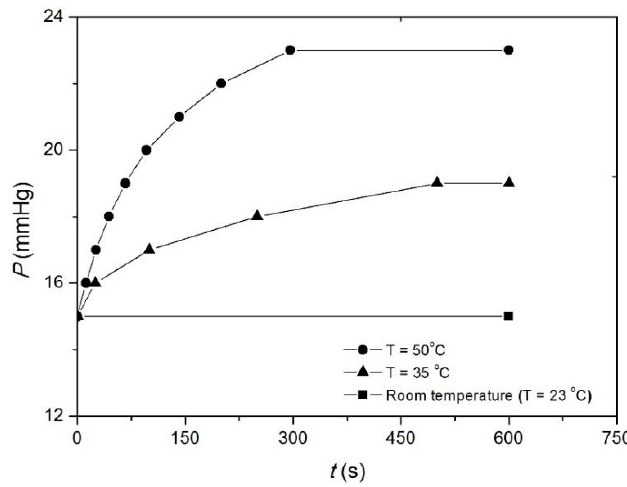
Figure 4. Pressure variation at different levels of temperatures (ε = 30%; C = 23.6 cm; N = 1).